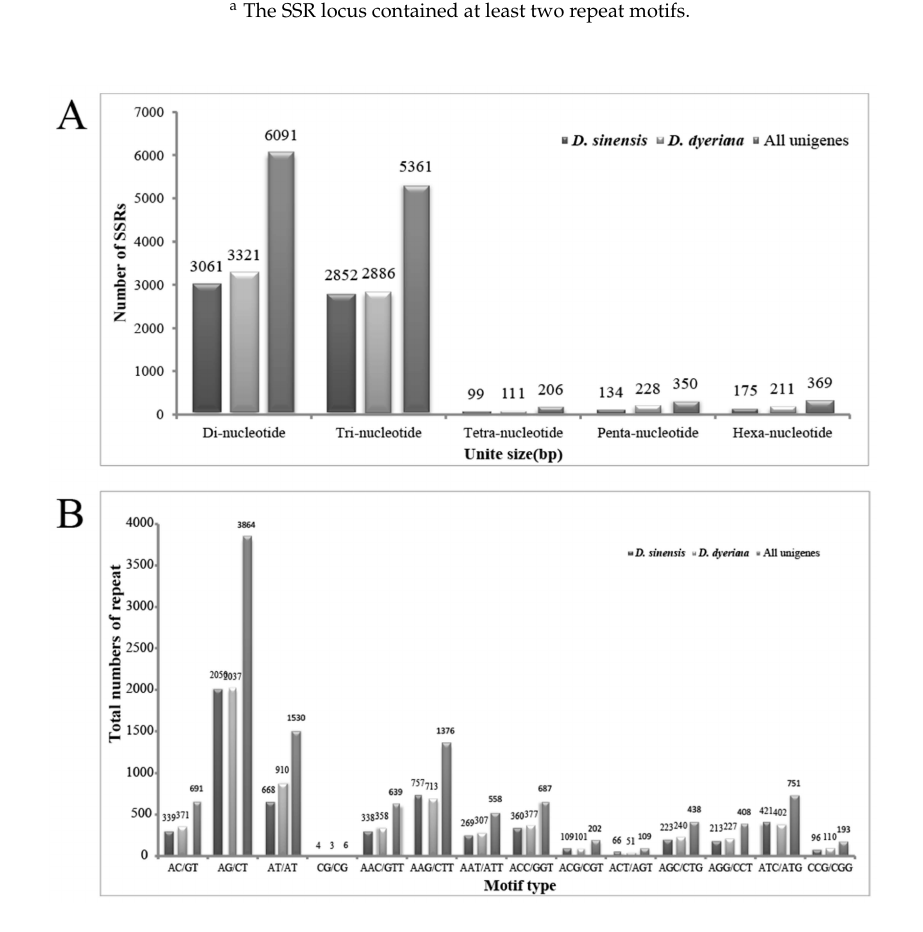
Figure 3. Frequency distribution of the SSRs identified in Dipteronia transcriptome. ( A ) Frequency distribution of the Dipteronia SSRs; ( B ) Total numbers of different SSR motifs in Dipteronia . Results of Di-nucleotides and Tri-nucleotides are